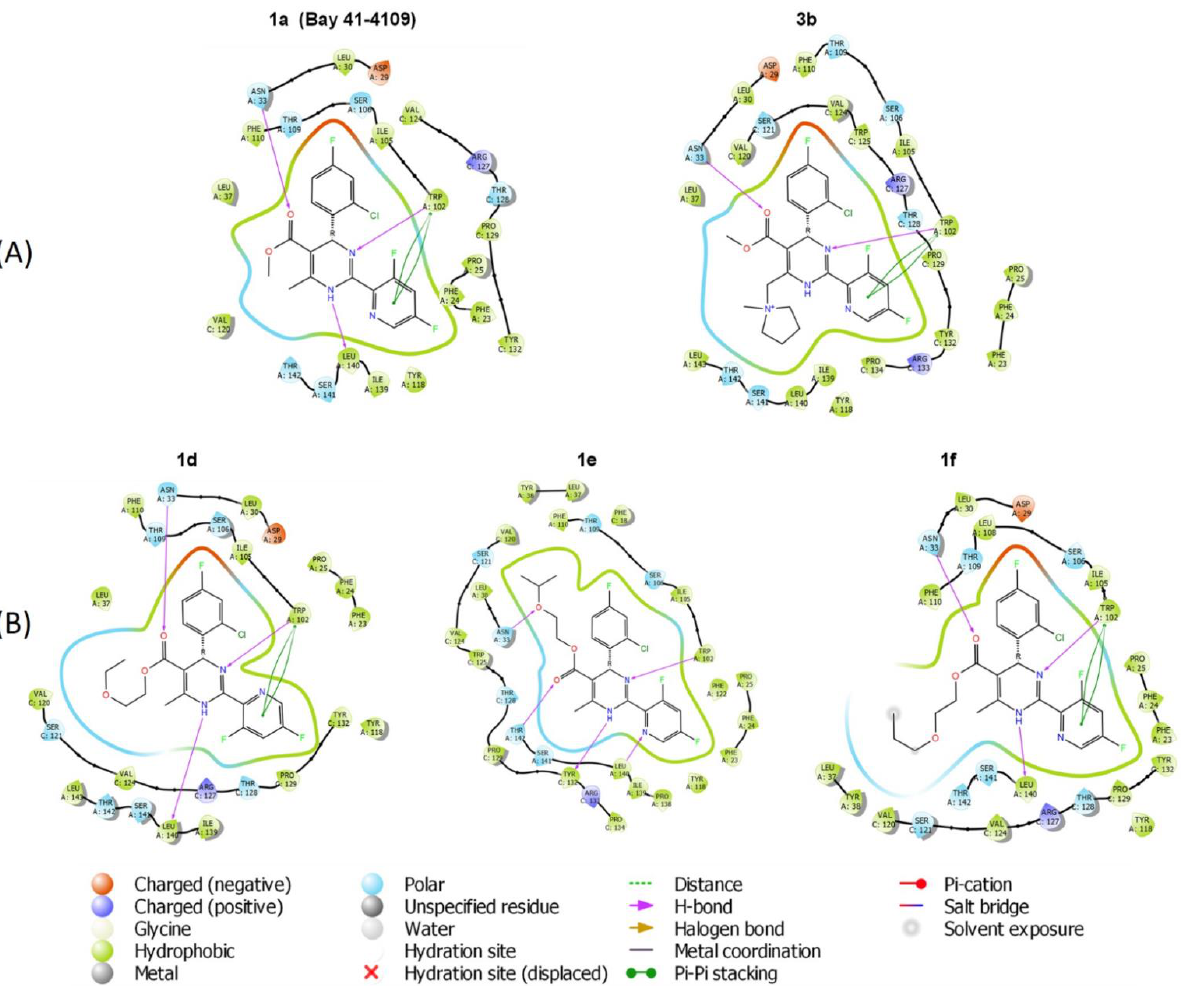
Figure 13. Interaction diagram of HAP compounds docked to HBc dimer interface. ( A ) Compounds 1a and 3b . ( B ) Compounds 1d , 1e and 1f .